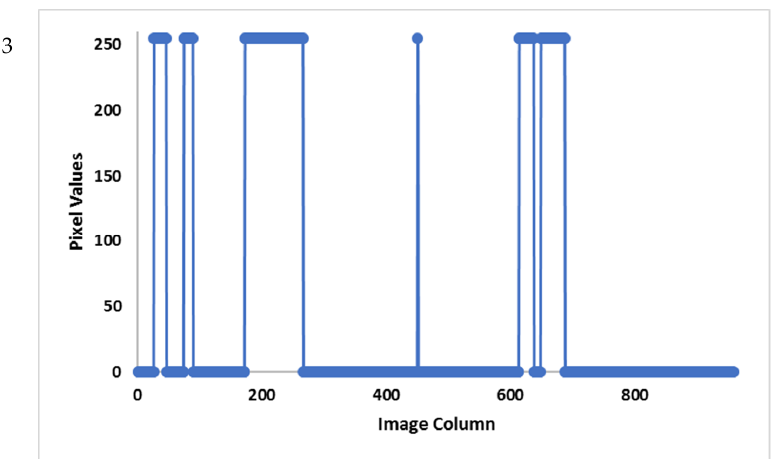
Figure 4. Depth map at the row pixel number 300 (each image has 540 row of pixels) ( 1 ); The pixels are captured in the histogram ( 2 ); and then using the 70th percentile only pixels with a value above 116 are used to form a binary image histogram ( 3 ).